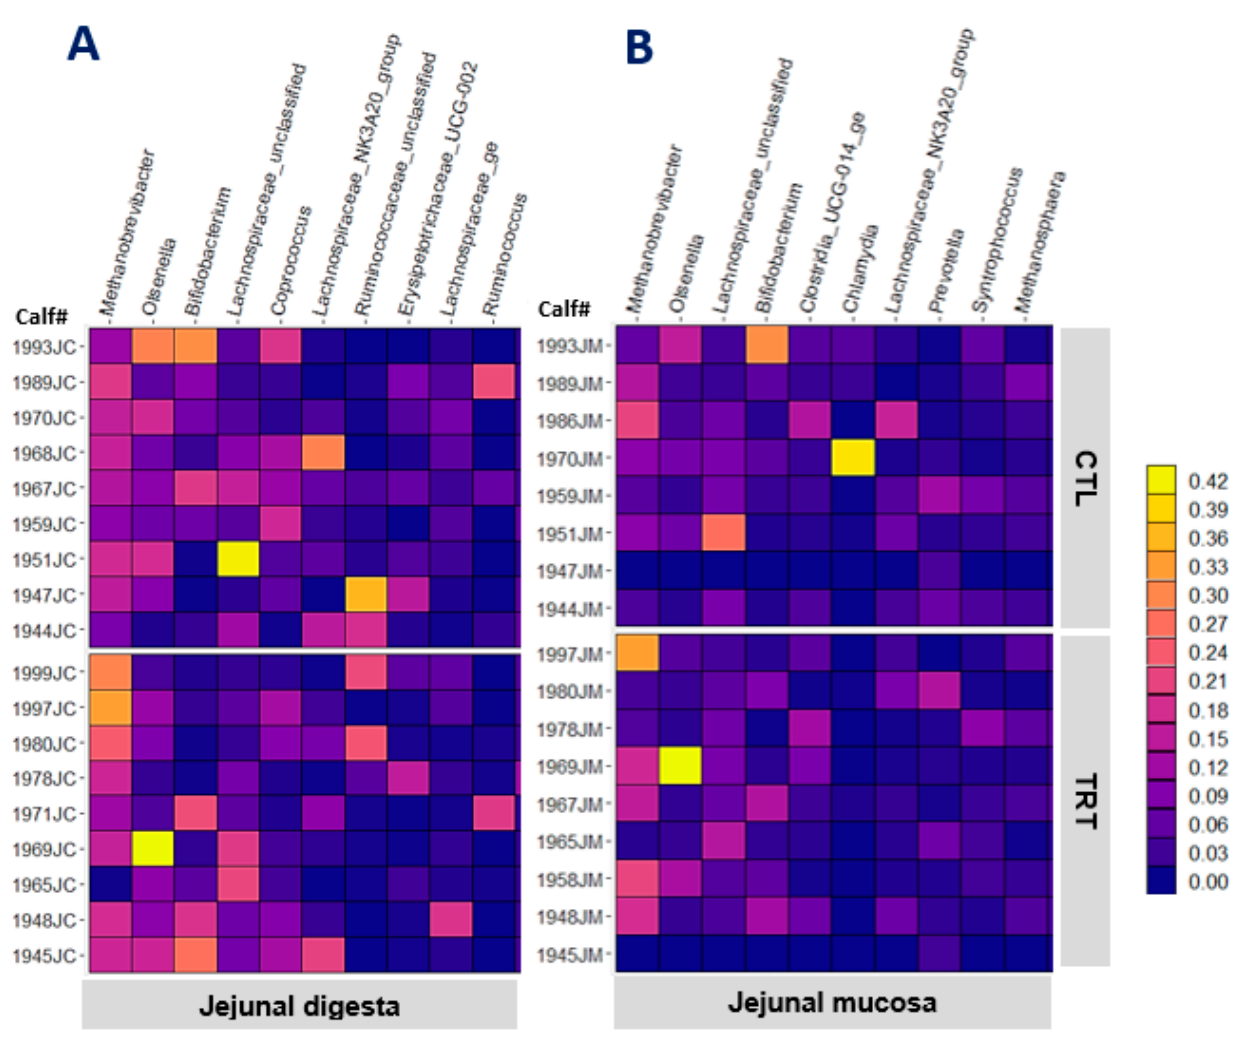
Figure 1. The relative abundance of the 10 most abundant genera in jejunal digesta ( A ) and jejunal mucosa ( B ) of weaned calves (95 d old) in control (CTL) and MCE-fed (TRT) groups. Table 4. Genera within the 50 most abundant showing differences ( p ≤ 0.05) between control (CTL) and MCE-fed (TRT) calves.